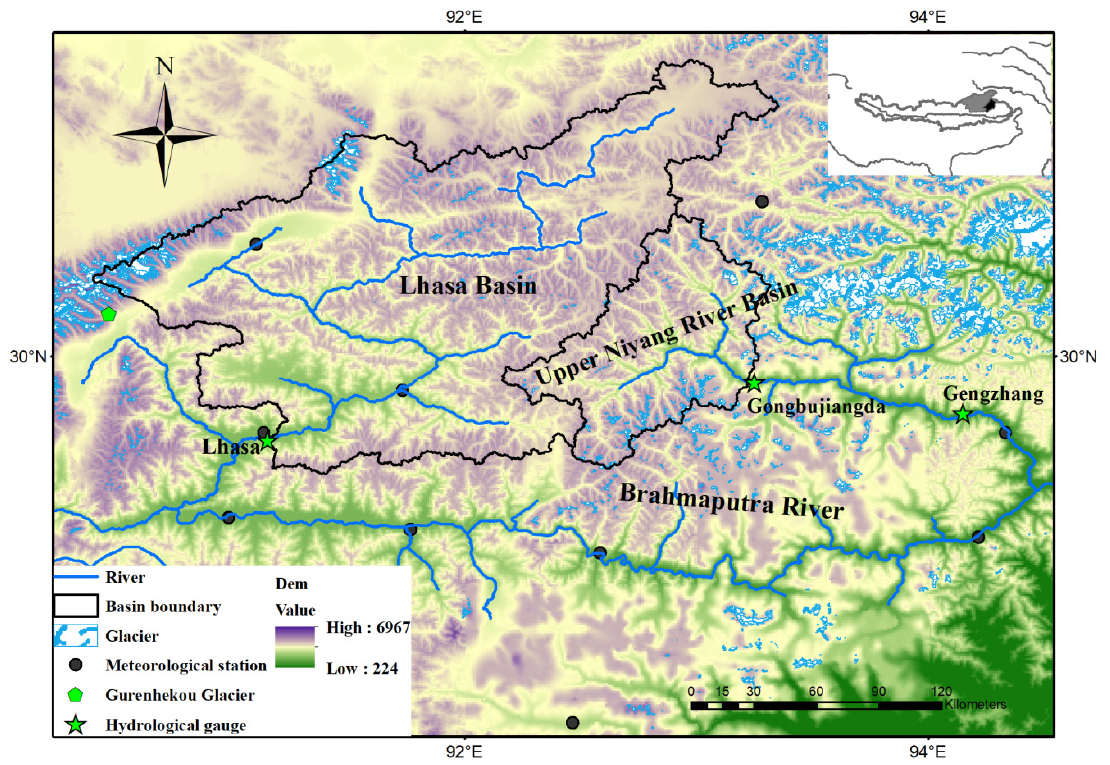
Figure 1. Location of the study basins, streamflow gauging stations, meteorological stations, elevations, and glaciers.